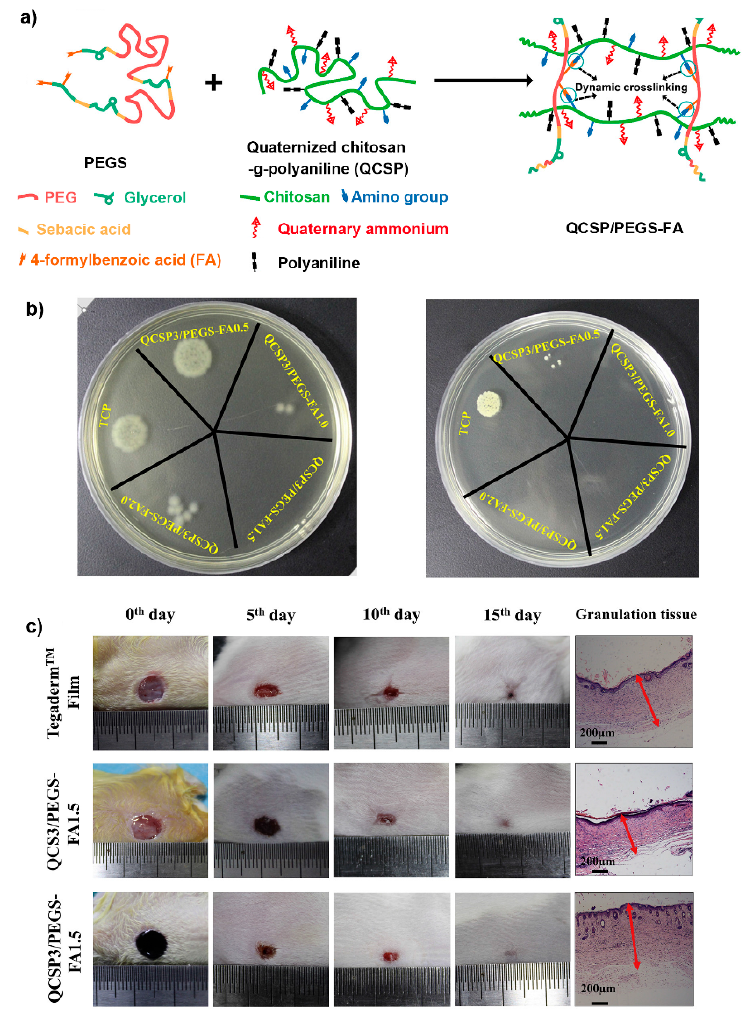
Figure 9. ( a ) The schematic illustration of the dynamic hydrogel; ( b ) photographs of survival bacteria, E. coli ( left ) and S. aureus ( right ), clones on agar plates after contacting with hydrogels: ( c ) photographs of wounds at the 0th, 5th, 10th, and 15th day and granulation tissue at the 15th day for commercial film dressing (Tegaderm™), hydrogel QCS3/PEGS-FA1.5 and hydrogel QCSP3/PEGS-FA1.5. Among all groups, the hydrogel QCSP3/PEGS-FA1.5 treated wound showed the smallest area and thickest granulation tissue. Reprinted with permission [50]. Copyright 2017, Elsevier Ltd.